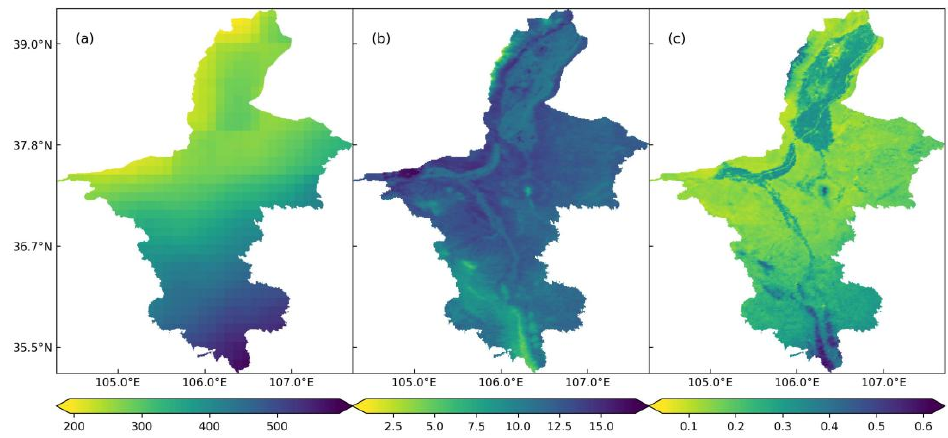
Figure 10. Spatial distribution of three influencing factors in Ningxia from 2001 to 2020. ( a , c ) Spatial distribution patterns of annual precipitation ( a ), annual surface temperature ( b ) and annual NDVI ( c ).